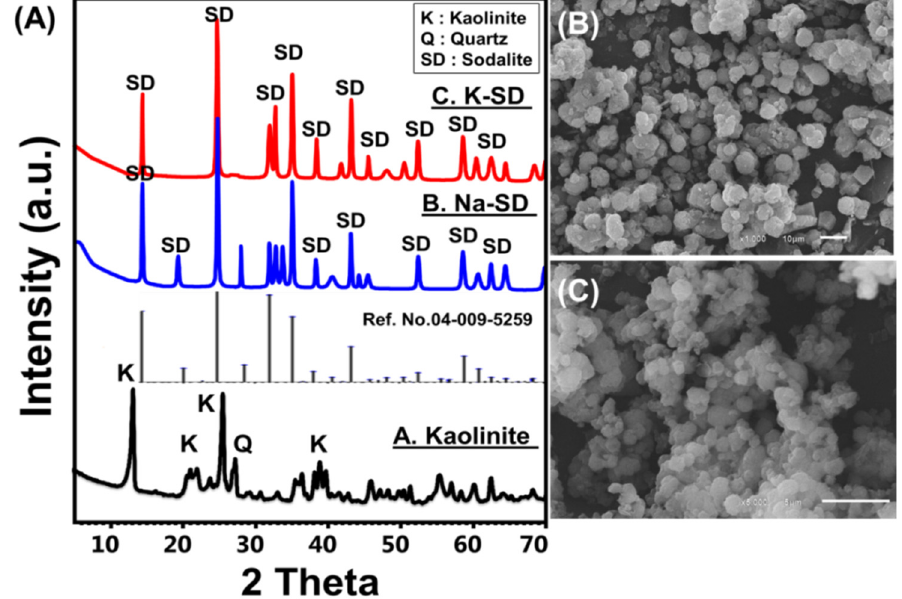
Figure 2. XRD patterns of kaolinite and the synthetic sodalite phases ( A ), SEM images of the prepared Na-sodalite (Na.SD) ( B ), and SEM images of K-sodalite (K.SD) ( C ).